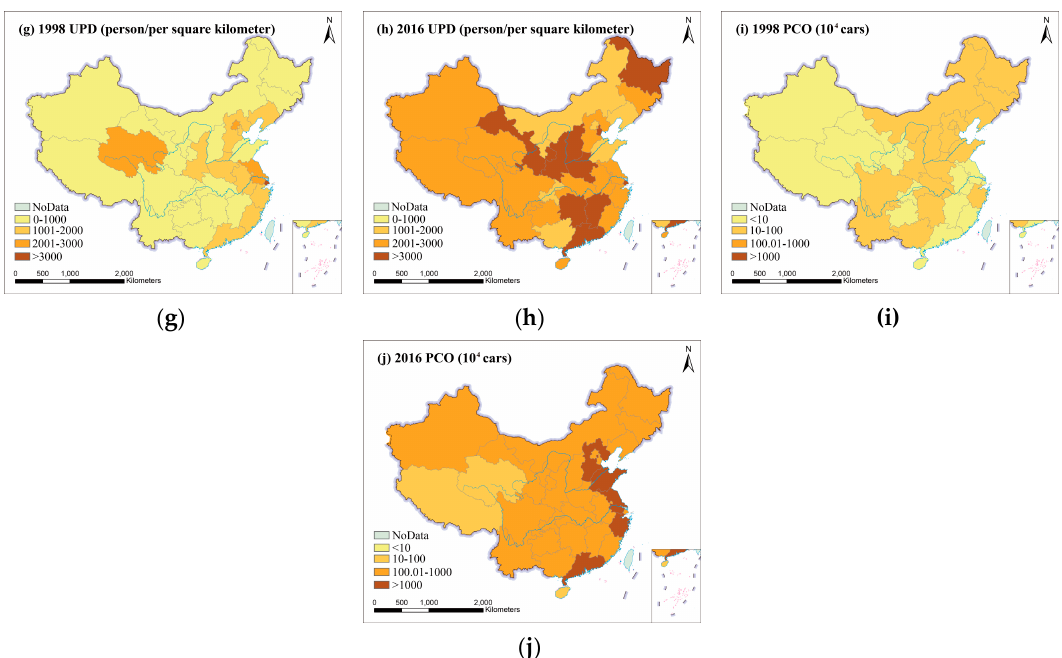
Figure 1. Spatial distribution of socioeconomic factors and PM 2.5 in 31 provinces of China in 1998 and 2016. ( a ) 1998 PM 2.5 , ( b ) 2016 PM 2.5 , ( c ) 1998 GDP per capita, ( d ) 2016 GDP per capita, ( e ) 1998 industrial added values, ( f ) 2016 industrial added values, ( g ) 1998 urban population density, ( h )